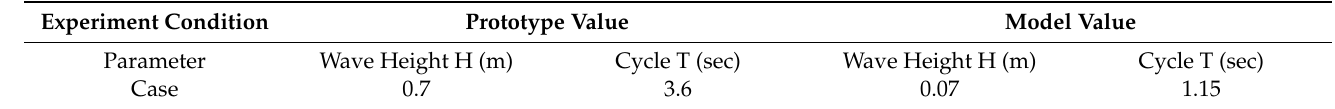
Table 2. Experiment condition.